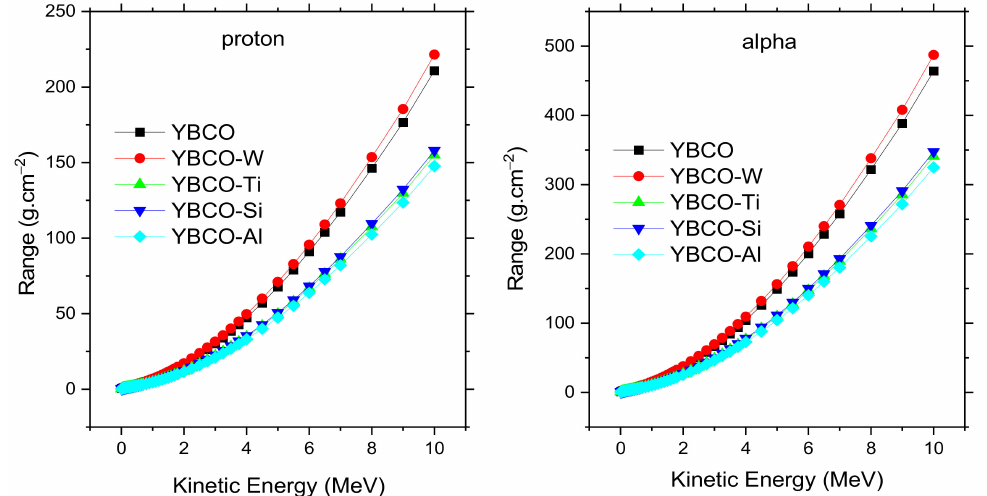
Figure 12. The range for proton and alpha versus the kinetic energy for fabricated ceramics.